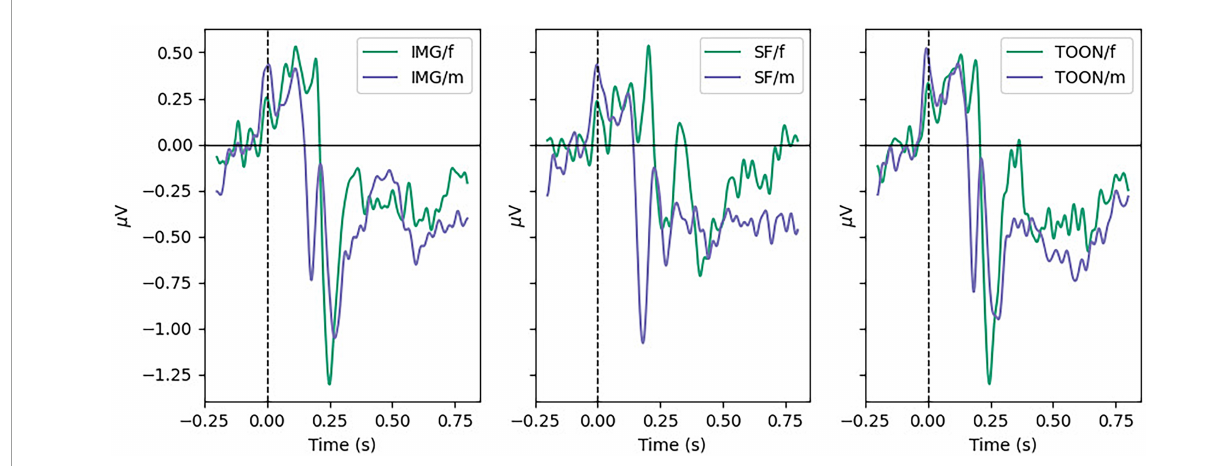
FIGURE5 Grand average ERP in temporal left ROI for male and female participants in each condition.